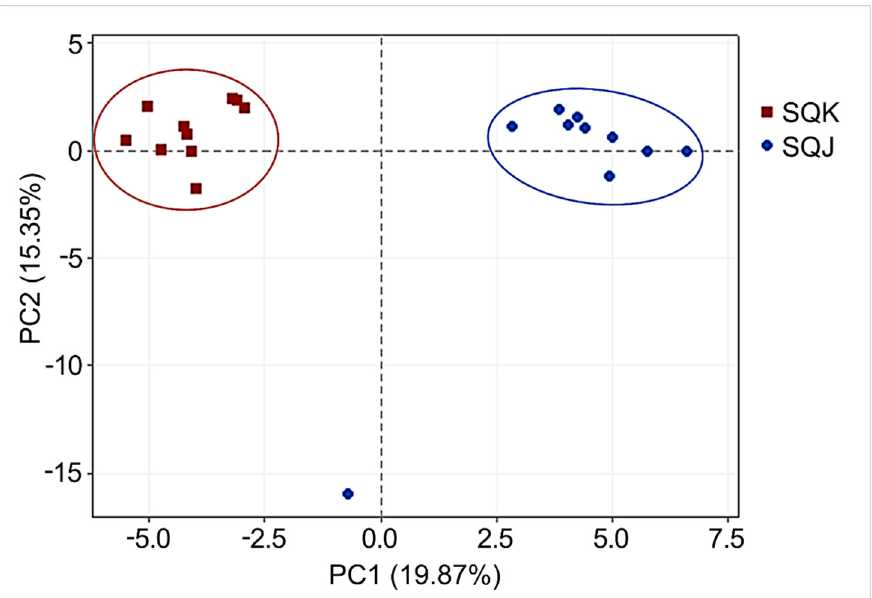
Figure 1. Principal component analysis (PCA) results. PC1 and PC2 show the first and second principal components, respectively. The numbers in parentheses show the contribution rates. The red dots indicate Korean yellowtail ( S. quinqueradiata Korean, SQK; n = 10) and the blue dots indicate Japanese yellowtail ( S. quinqueradiata Japanese, SQJ; n = 10).